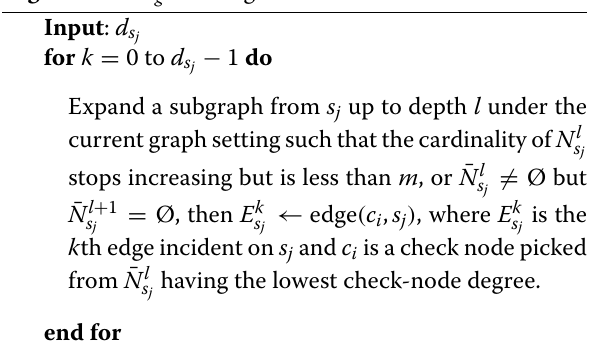
Algorithm 3 P g -PEG algorithm